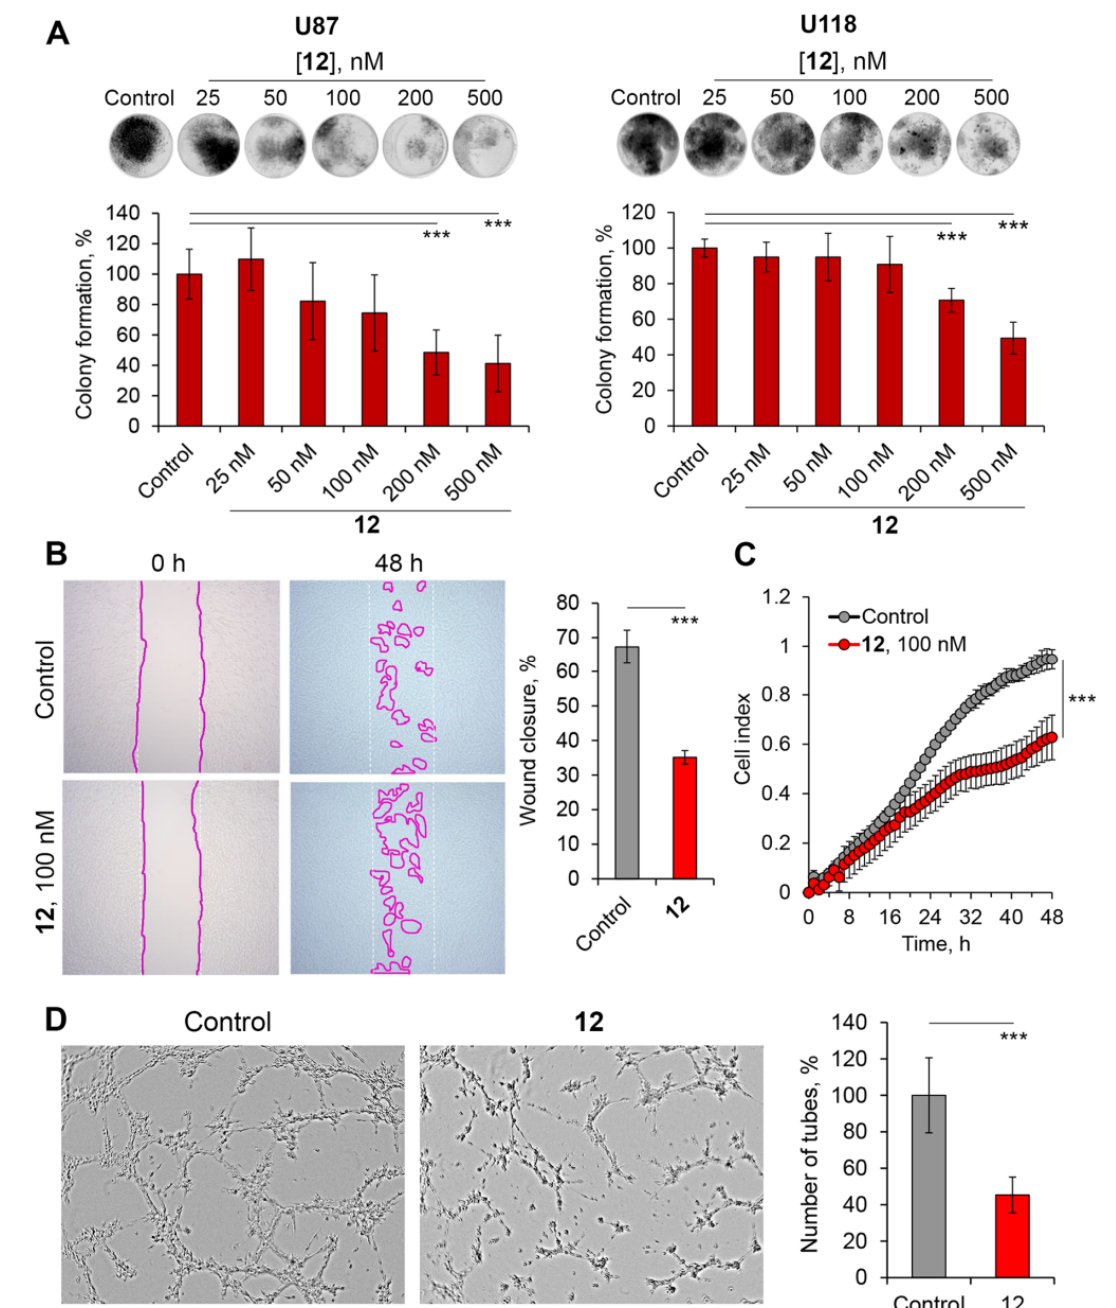
Figure 7. Anti-glioblastoma potential of 12 at non-toxic concentrations in vitro. ( A ) The effect of 12 on the clonogenic capacity of glioblastoma cells. Representative images and the colony forming efficiency of U87 and U118 cells incubated with 12 (25–500 nM) for 14 days. The data are expressed as means ± SD of six independent experiments. ( B ) The effect of 12 on the 2D motility of glioblastoma cells. Representative images from the results of the scratch assay in U118 cells. Quantitative data are presented as the means ± SD of three independent experiments. ( C ) The effect of 12 on trans-well (3D) motility of glioblastoma cells. xCelligence was used to monitor the real-time cell migration. The experiment was performed in quadruplicate. ( D ) The influence of 12 on vasculogenic mimicry in U87 glioblastoma cells. U87 cells were seeded into Matrigel-coated wells and allowed to form tubular structures in the presence or absence of 12 (200 nM) for 5 h. Quantitative data are presented as the means ± SD of three independent experiments. *** p < 0.001.